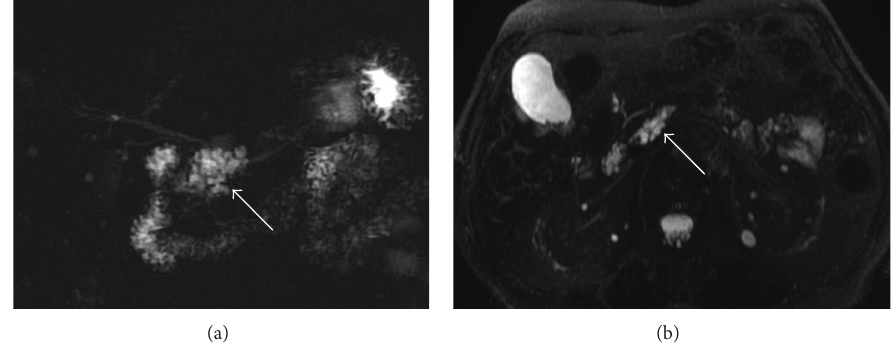
Figure 3: MRCP images (a and b), obtained using 2D FSE sequence and 3D FRFSE technique, respectively. BD-IPMN of about 3 centimeters located in the uncinate process of pancreas, with a typical microcystic appearance. No other worrisome features were found by EUS; the patient was successfully enrolled in a follow-up